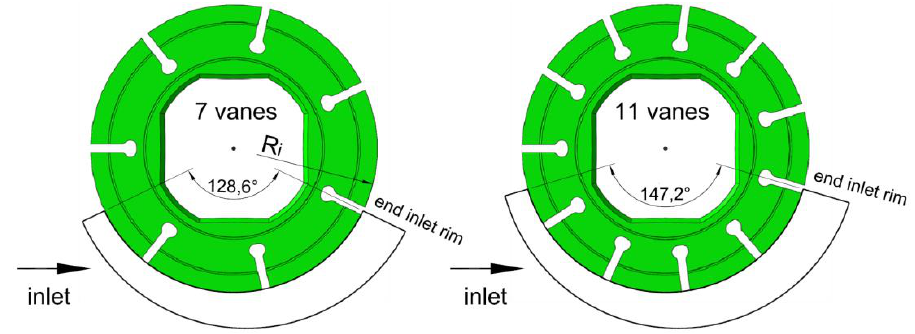
Figure 12. Rotors with different numbers of vanes, and the profile of the suction port plate.